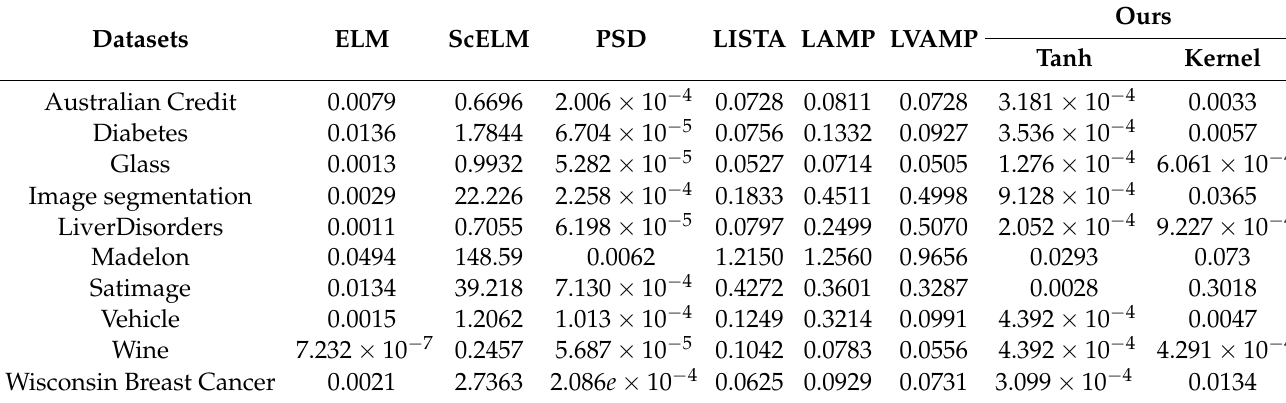
Figure 5 (The Tanh and Kernel mean the tanh version and kernel version of our method, respectively.) shows the confusion matrices obtained by this proposed method, PSD, LISTA, LAMP and LVAMP on Satimage dataset, in which the kernel version of this proposed method achieved a much better recognition result than others. It can be seen from this figure that all methods almost fail to correctly classify the test samples of class 4 except the kernel version of our method. It indicates that the features computed by this proposed method are more discriminative than that of other approximation methods. Figure 6 shows two examples of the receiver operating characteristic (ROC) curves of the approximation methods, where the red lines report the performance of our approach. It is clear that the Areas Under ROC curves (AUC) of our approach is much higher than